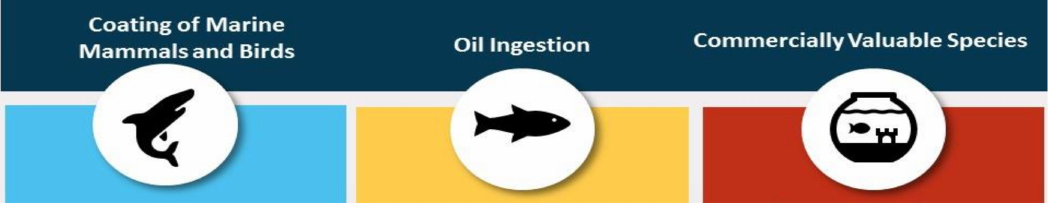
Figure 4. Oil spill in marine environment and ways to affect